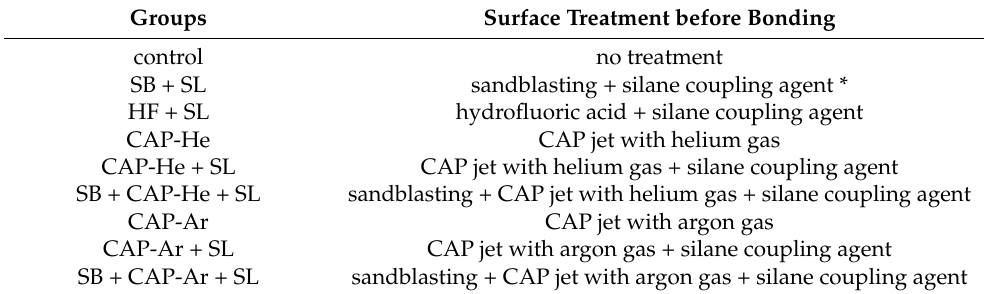
Table 2. Different surface treatment of nine groups before binding.